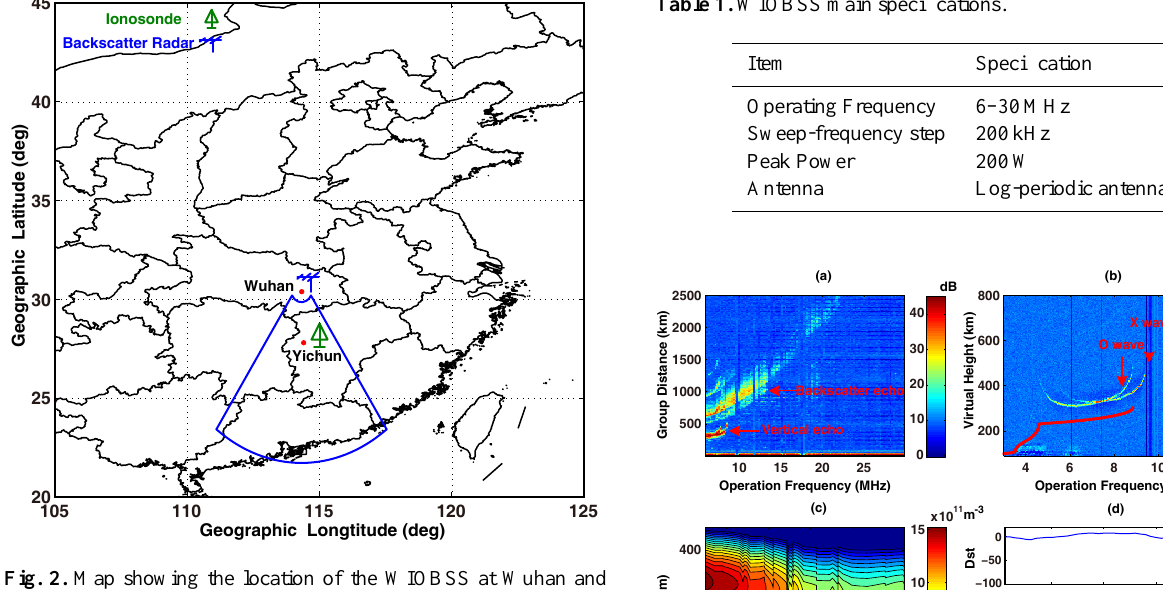
Table 1. WIOBSS main specifications.